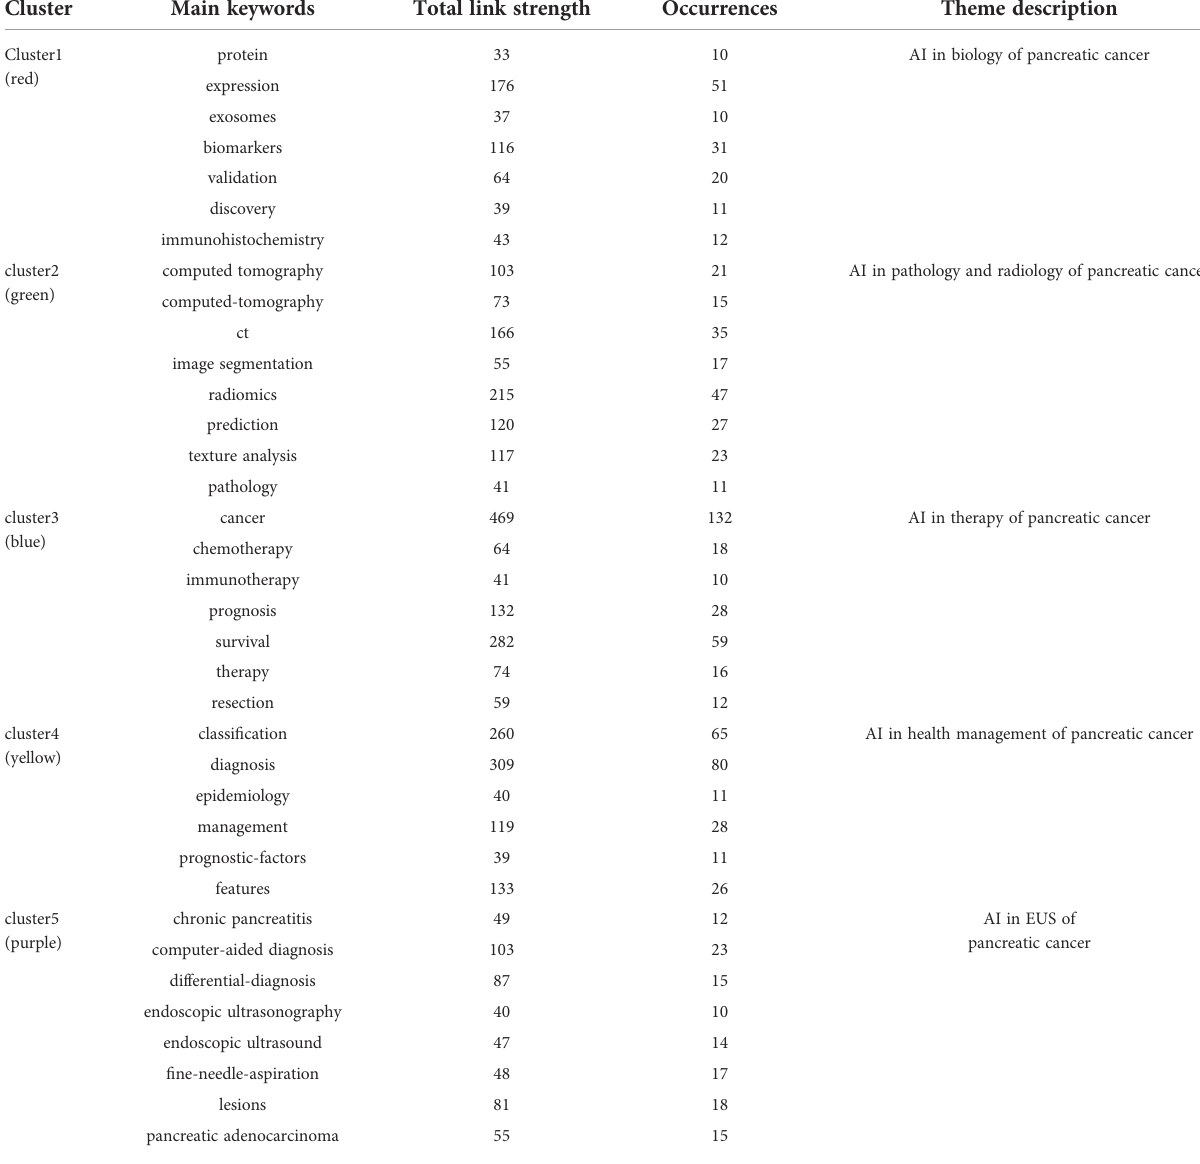
TABLE 5 Highly frequent major keywords in each cluster.